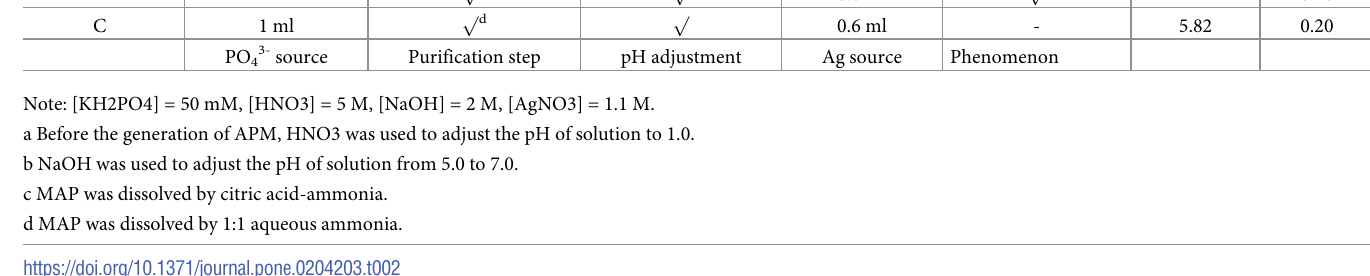
PLOS ONE | https://doi.org/10.1371/journal.pone.0204203 September 20,